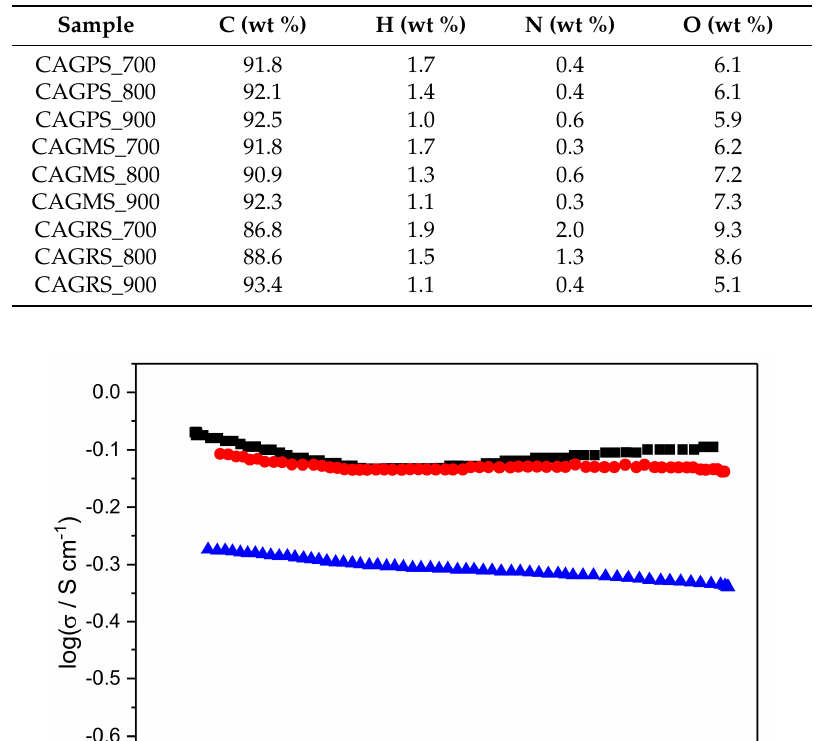
Table 2. The results of elemental analysis of carbon aerogels.